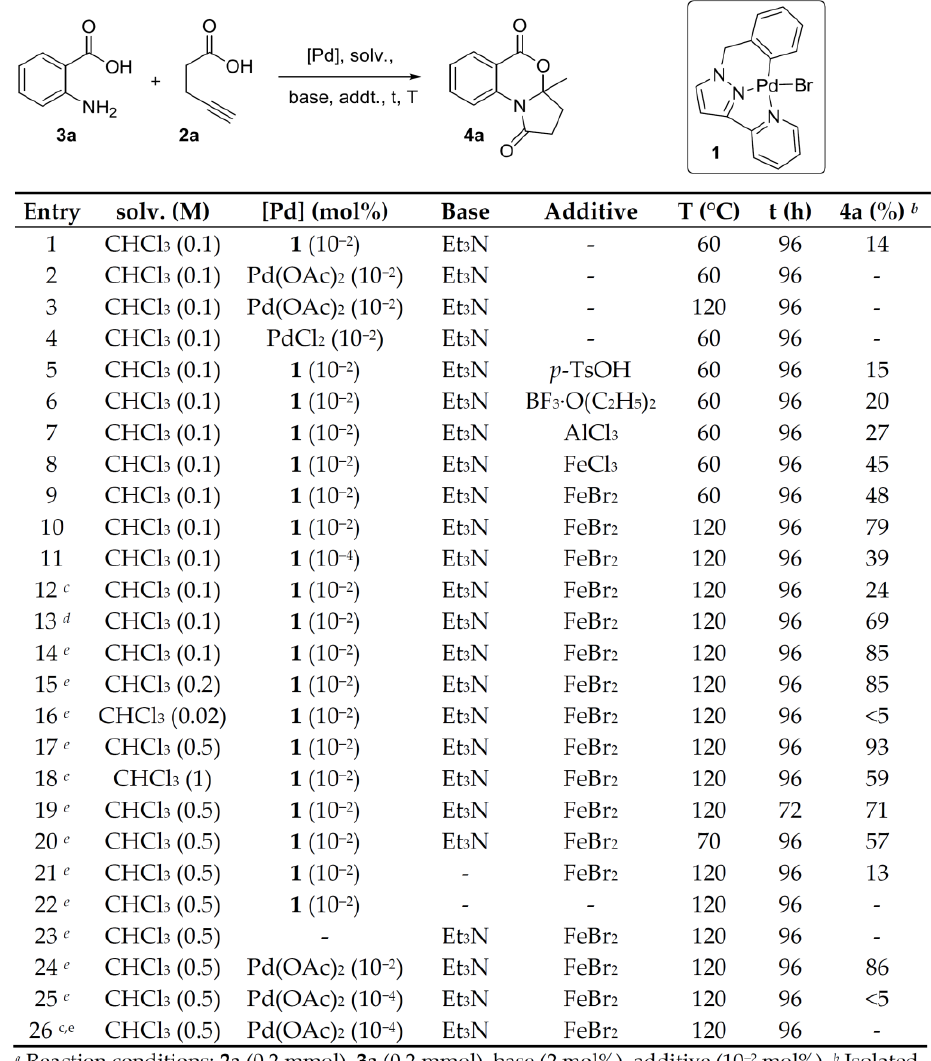
Figure 2. Palladium-catalyzed formation of benzo[ d ]pyrrolo [2,1- b ]oxazine-1,5-dione 4a . Selected optimization experiments a .